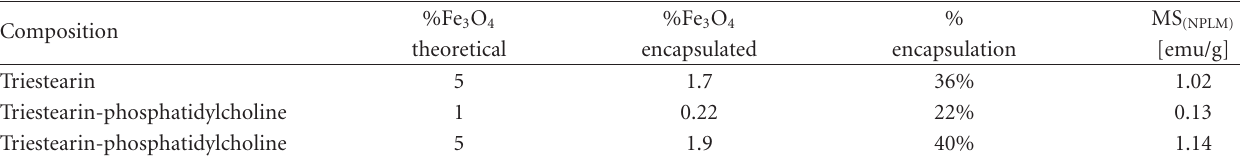
Table 4: E ffi ciency of magnetite nanoparticles encapsulation in the lipid particles and their saturation magnetization. %Fe 3 O 4 Composition theoretical encapsulated encapsulation [emu/g] Triestearin